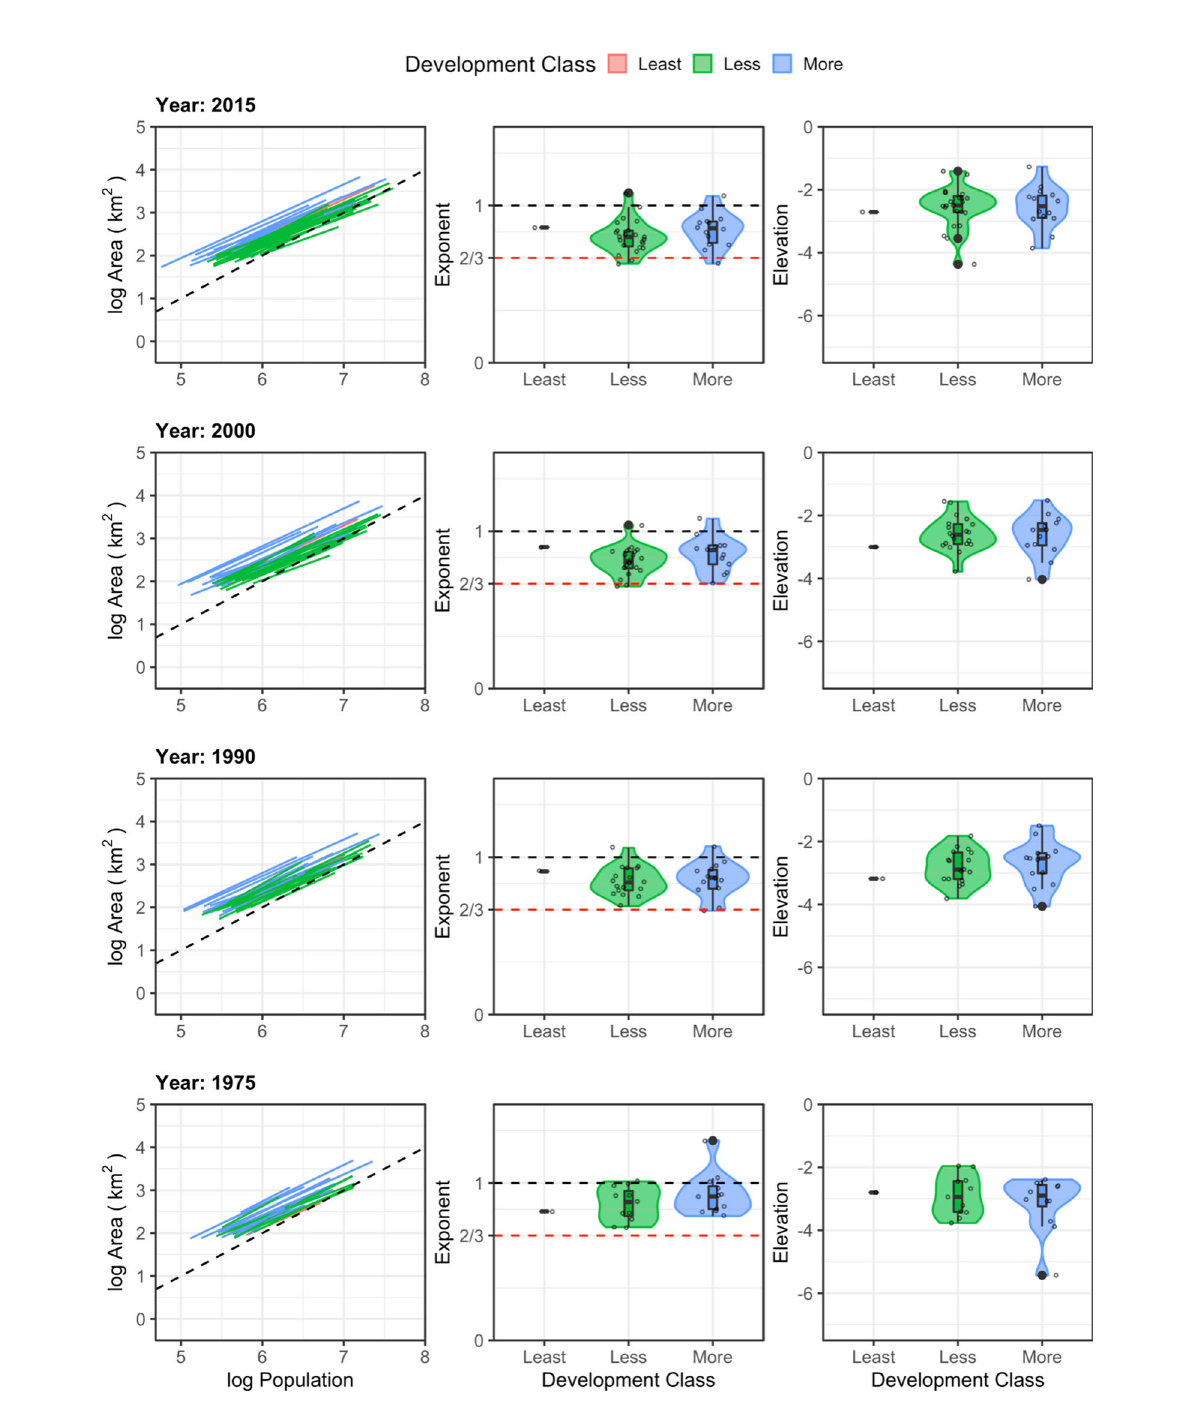
FIGURE 4 Comparison of log area~ log population scaling for GHS dataset for different decades. Black dashed lines represent the 1/1 line (e.g., a = 1). All regressions (Reduced Major Axis) are country-level with at least 5 cities of > 50,000 people and >= 100 km 2 for the speci fi c